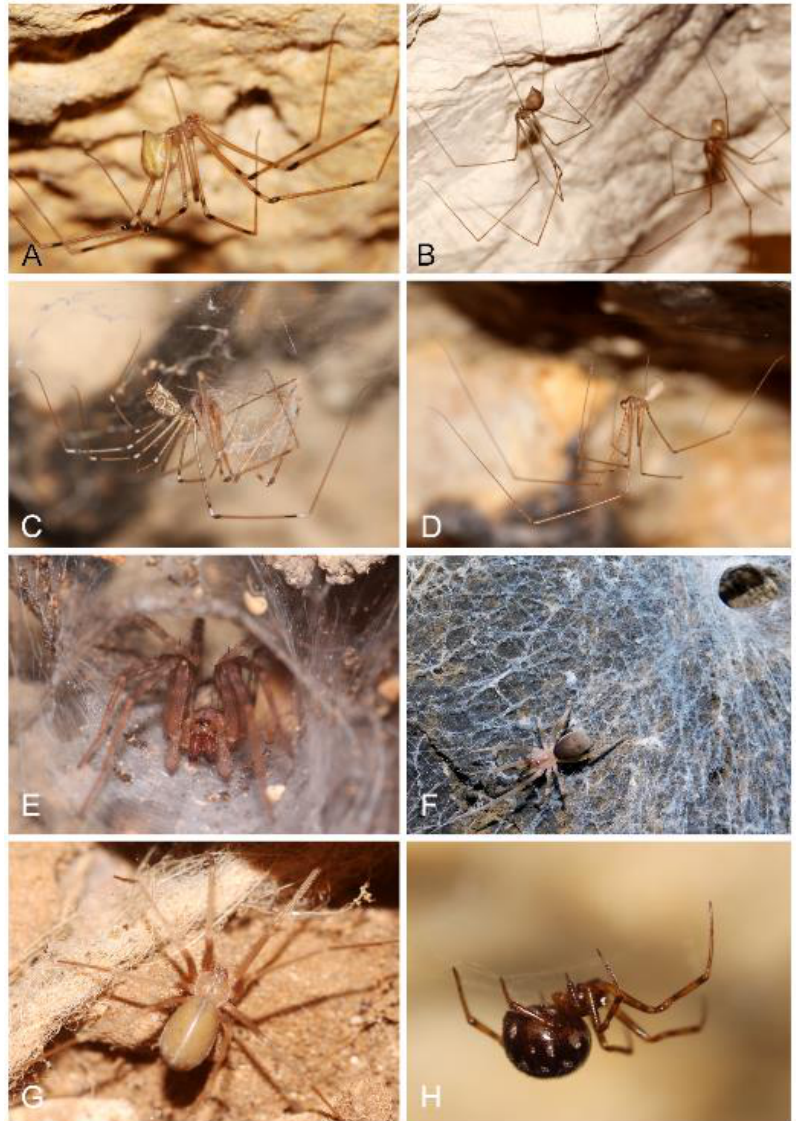
Figure 8. Eight of the nine most abundant troglophile spiders found during cave surveys (cave numbers in parentheses). ( A – D ): Pholcidae: ( A ): Artema nephilit Aharon, Huber and Gavish-Regev 2017 from Oren medium cave (Karmel ridge, 10); ( B ): Hoplopholcus cecconii Kulczyński, 1908 from Yir’on large cave (upper Galilee, 2); ( C ) : Holocnemus pluchei Scopoli, 1763 from a cave in Perat wadi (northern Judean desert, 19–22); ( D ): Pholcus Walckenaer, 1805 from ‘Inbal cave 1 in Perat wadi (northern Judean desert); ( E ): Tegenaria pagana C. L. Koch, 1840 (Agelenidae) from Teomim cave (Judean mountains); ( F ): Filistata insidiatrix (Forskål, 1775) from ‘Inbal cave 1 in Perat wadi (northern Judean desert, 20); ( G ): Loxosceles rufescens (Dufour, 1820) (Sicaridae) from Berniki caves (lower Galilee, 7–9); ( H ): Steatoda triangulosa (Walckenaer, 1802) (Theridiidae) from Tinshemet cave (western Samaria, 17). Pictures: ( A – E ), ( G , H ): Shlomi Aharon, ( F ): Igor Armiach Steinptress.